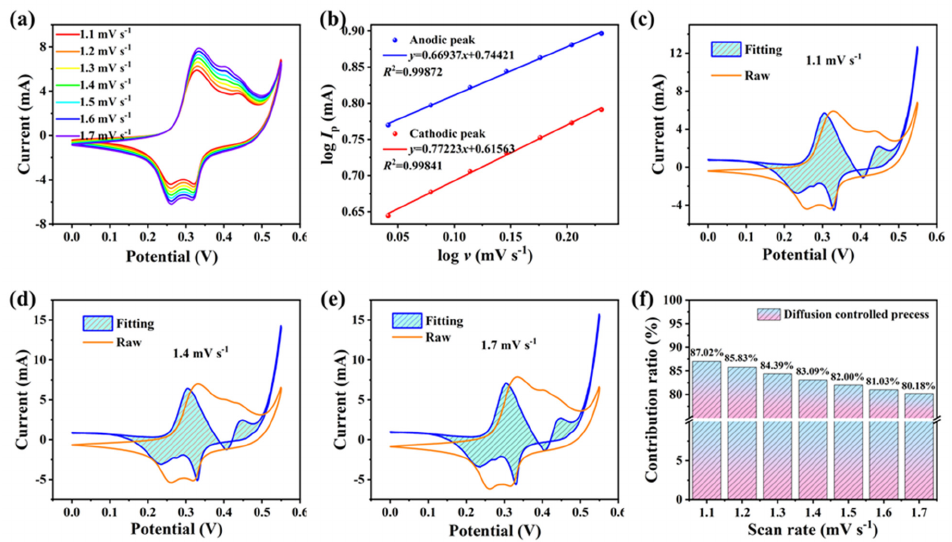
Figure 6. ( a ) The CV curves of Ni 2 Co 1 S 4 at small scan rates, ( b ) the fitted lines of log I p vs. log v , ( c – e ) the original CV curves and fitting CV curves at 2.0, 3.5, and 5.0 mV s − 1 , ( f ) the contribution ratio of the diffusion-controlled current at different scan rates.